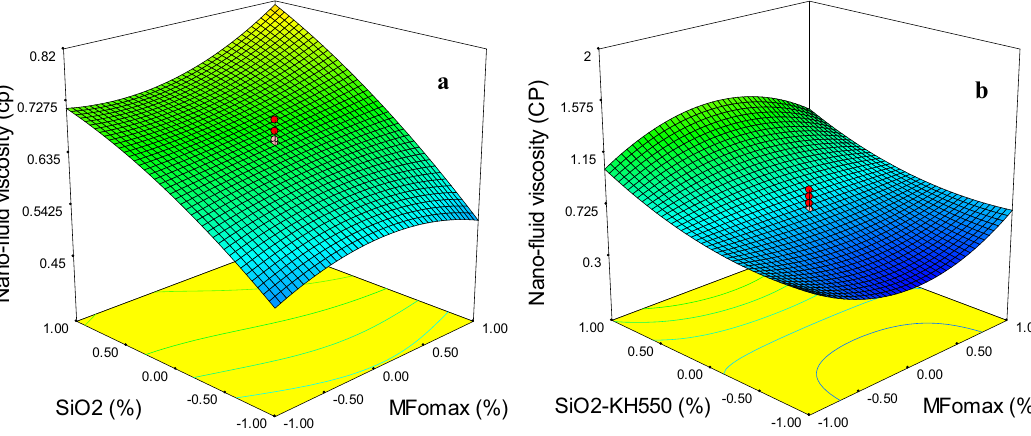
Fig. 3 Effect of NPs loading on the NF’s viscosity; the x axis represents the concentrations presented in terms of the coded value which indicate the lowest value to be 0.1% (− 1) and the highest 0.5% (1.0)